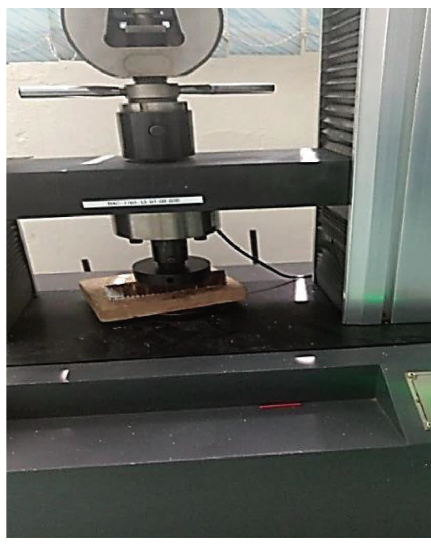
Figure 12: Setup of the compression test.